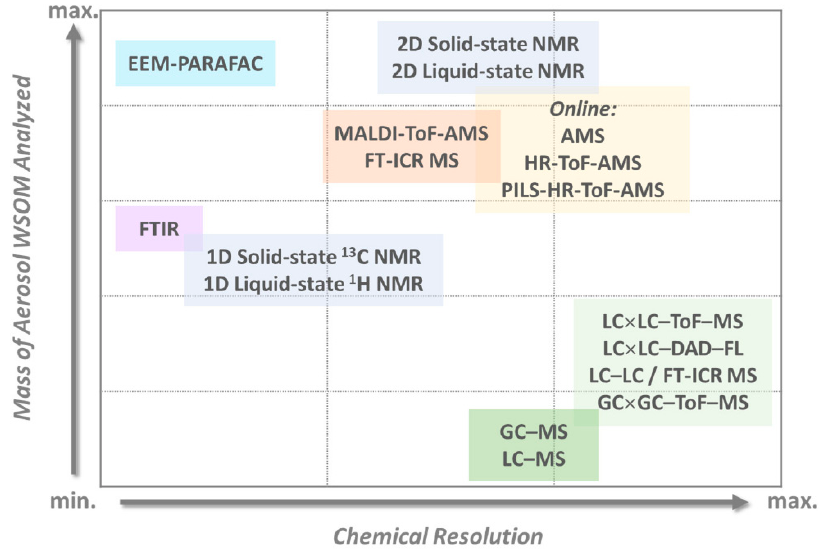
Figure 9. Schematic illustration of the analytical strategies most currently employed in the struc- tural and chemical characterization of aerosol water soluble organic matter (WSOM), considering its amount versus the chemical resolution of the applied methodology [119].